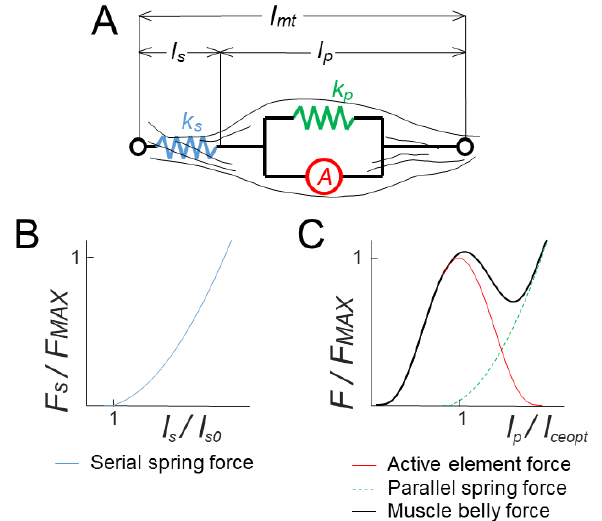
Figure 2. The Hill musculotendon model. ( A ). The musculotendon system is modeled with an active element A and a parallel spring (k p ), which modulates the action of the muscle belly fibers, and a serial spring (k s ), which modulates the tendons action. ( B ). The force exerted by the serial spring, depending on the relative length of the tendons (l s /l s0 ). ( C ). The force exerted by the muscle belly (black) as the sum of the action exerted by the parallel spring (green) and by the active element (red). The magnitude of the exerted force depends on the relative length of the belly (l p /l ceopt ).